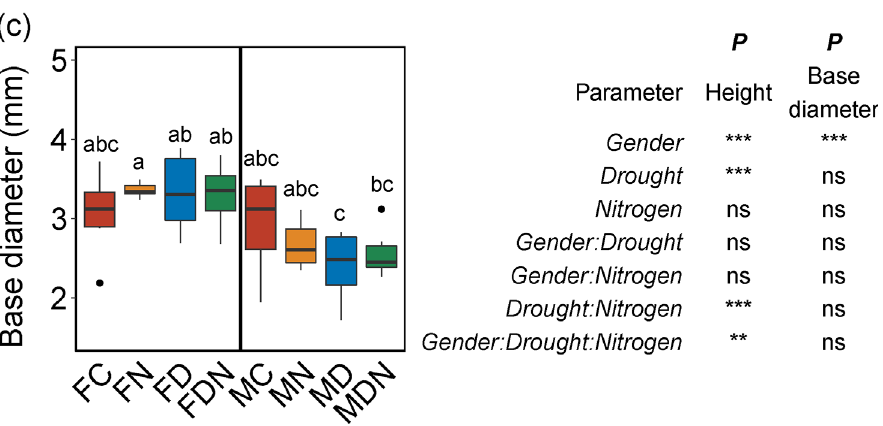
Figure 1. The phenotypic parameters of S. myrtillacea cuttings. ( a ) Morphology of cuttings after treatments. The black line denotes 10 cm length; ( b ) the height of cuttings ( n = 6); ( c ) the base diameter of cuttings ( n = 6). F, females; M, males; C, control; N, N deposition; D, drought; DN, drought and N deposition. The double dagger (‡) indicates simple effect of gender, the dagger (†) indicates simple effect of drought, and the inverted dagger ( ⸸ ) indicates simple effect of N deposition. Different letters indicate significant differences (Tukey test, p < 0.05). The black dot indicates outlier. Asterisks denote significant differences: ***, p < 0.001; **, p < 0.01.